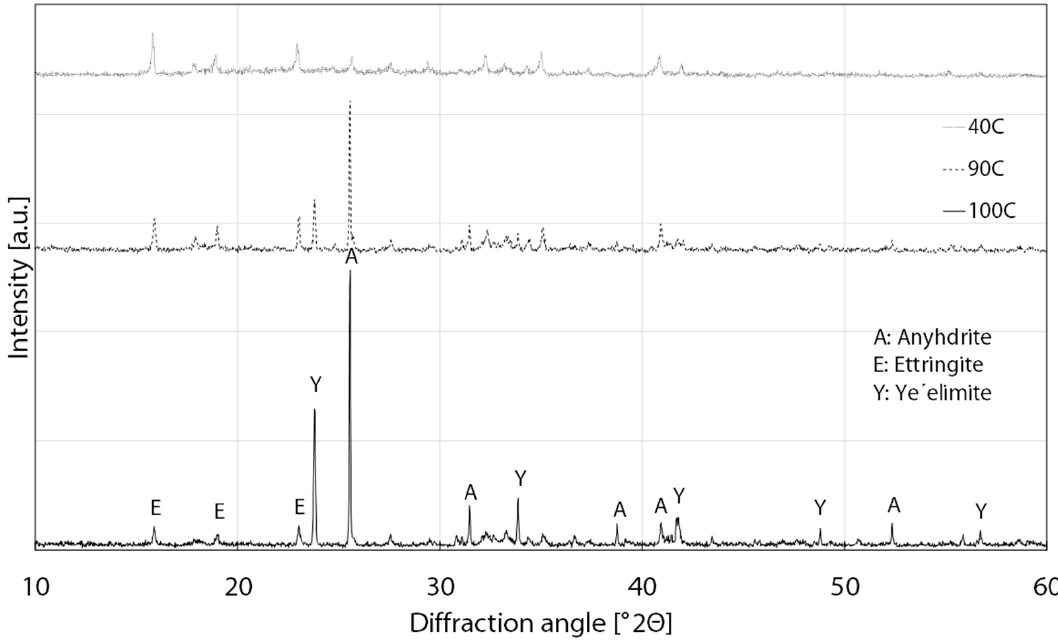
Figure 10. XRD diffractograms of the following samples after 14 days of hydration: 100C (solid line), 90C (dotted line), and 40C (dashed line).